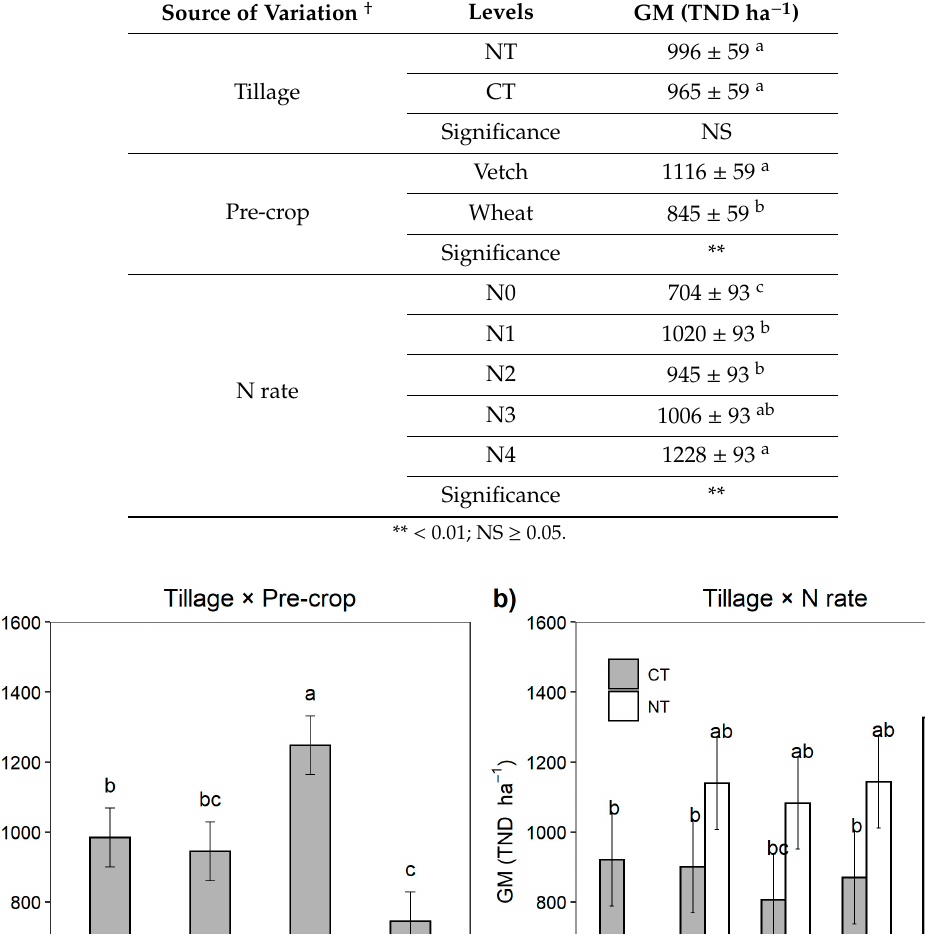
Table 4. Significance from ANOVA testing effect of tillage practices (CT and NT), previous crop (bread wheat and vetch), and nitrogen rate (N0, N1, N2, N3, and N4) on gross margins (GM). Data are averages ± standard errors. Different lowercase letters indicate significant differences between all treatments each item ( p < 0.05). † Tillage, tillage practices; Pre-crop, previous crop; N rate, nitrogen rate.